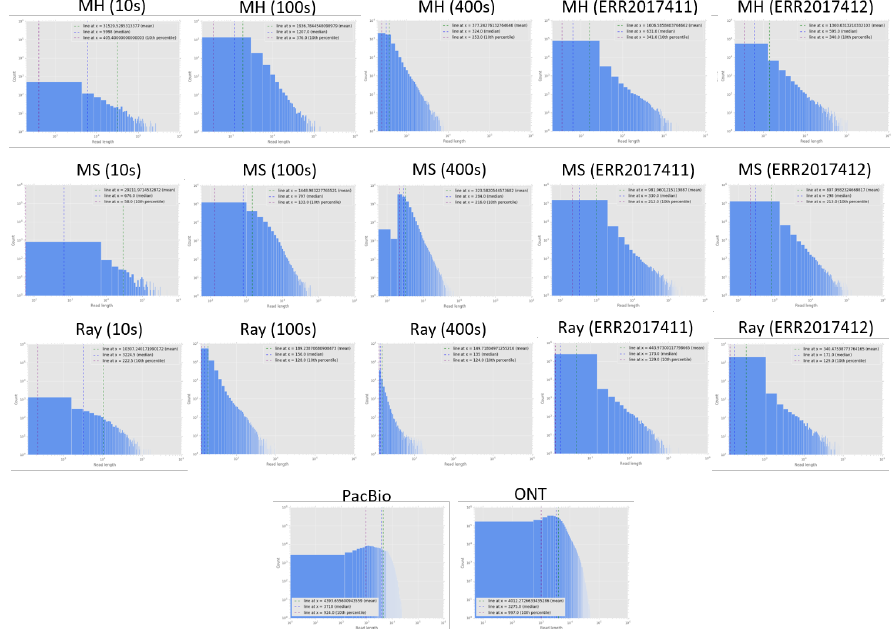
Figure 2. Contig length distribution compared to PacBio and ONT long read length distribution. Contigs were assembled across datasets (from left to right): 10s, 100s, 400s, ERR2017411, ERR2017412 and by different assemblers (from top to bottom): MEGAHIT (MH), metaSPAdes (MS), Ray. The bottom subfigures are PacBio (left) and ONT (right) read length